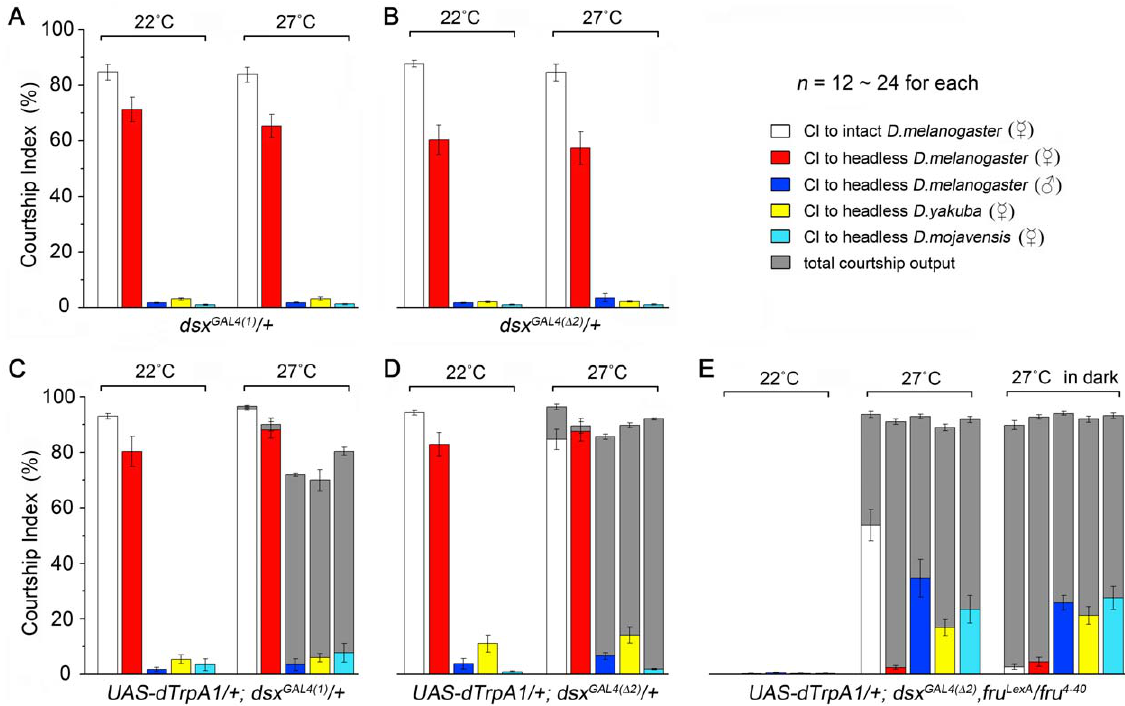
Figure 6. Activation of dsx neurons promotes courtship in the absence of FRU M . (A–E) Courtship indices of males of the indicated genotypes paired with D. melanogaster females (white), headless D. melanogaster females (red), headless D. melanogaster males (blue), headless females of D. yakuba (yellow) and D. mojavensis (cyan). (A–B) Males with only dsx GAL4 (either dsx GAL4(1) or dsx GAL4( D 2) ) but no UAS-dTrpA1 court D. melanogaster females normally, and rarely court other inappropriate targets at either 22 u C or 27 u C. (C–D) Activation of all dsx neurons induced consistently high level of courtship outputs in males at 27 u C (gray), independent of the presence of any target; however, these males only directed courtship persistently to D. melanogaster female targets. Courtship indices to headless D. melanogaster males, headless females of D. yakuba and D. mojavensis are not significantly different from those acquired at 22 u C ( p . 0.05 for all, two sample t-test). (E) Activation of all dsx neurons in fru M null males ( fru LexA / fru 4–40 ) promoted courtship to intact D. melanogaster females in the light but not the dark. These males did not court headless D. melanogaster females in light or dark, but they directed courtship to headless males and other species in both the light and the dark. n indicates number of males tested. Error bars indicate